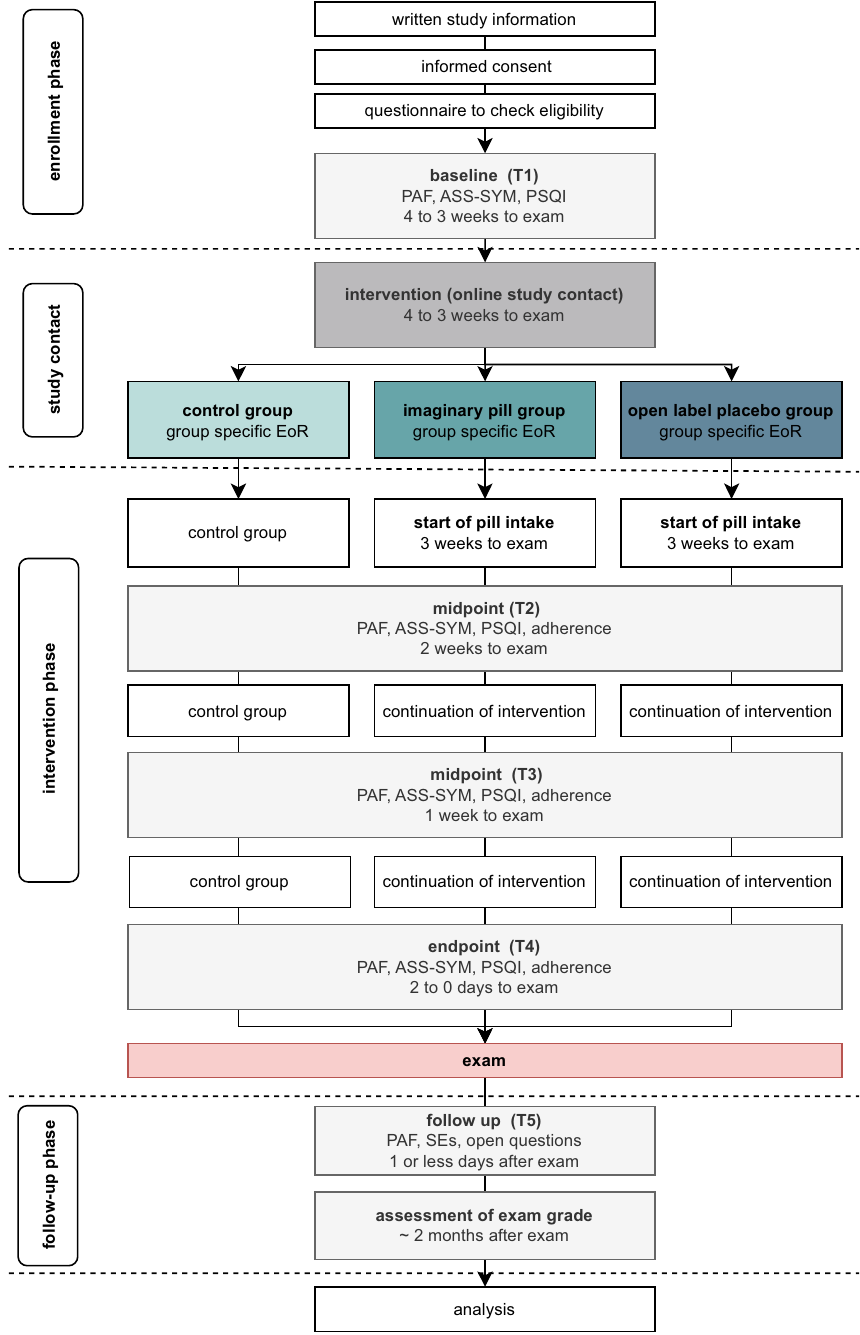
Figure 5. Procedure of the study. Note: ASS-SYM Änderungssensitive Symptomliste (general well-being), EoR expectancy of test anxiety relief, PAF Prüfungsangstfragebogen (test anxiety questionnaire), PSQI pittsburgh sleep quality index, SEs side-effects, SDD sociodemographic